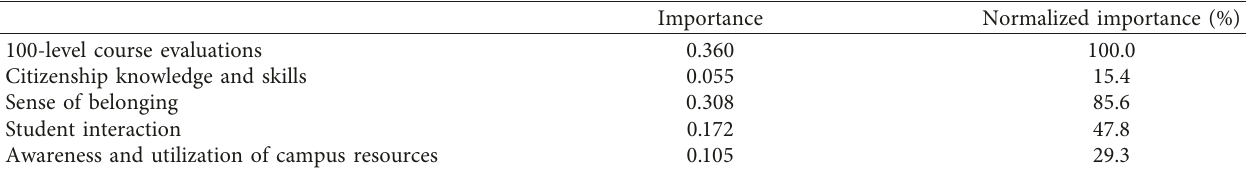
Table 16: Independent variable